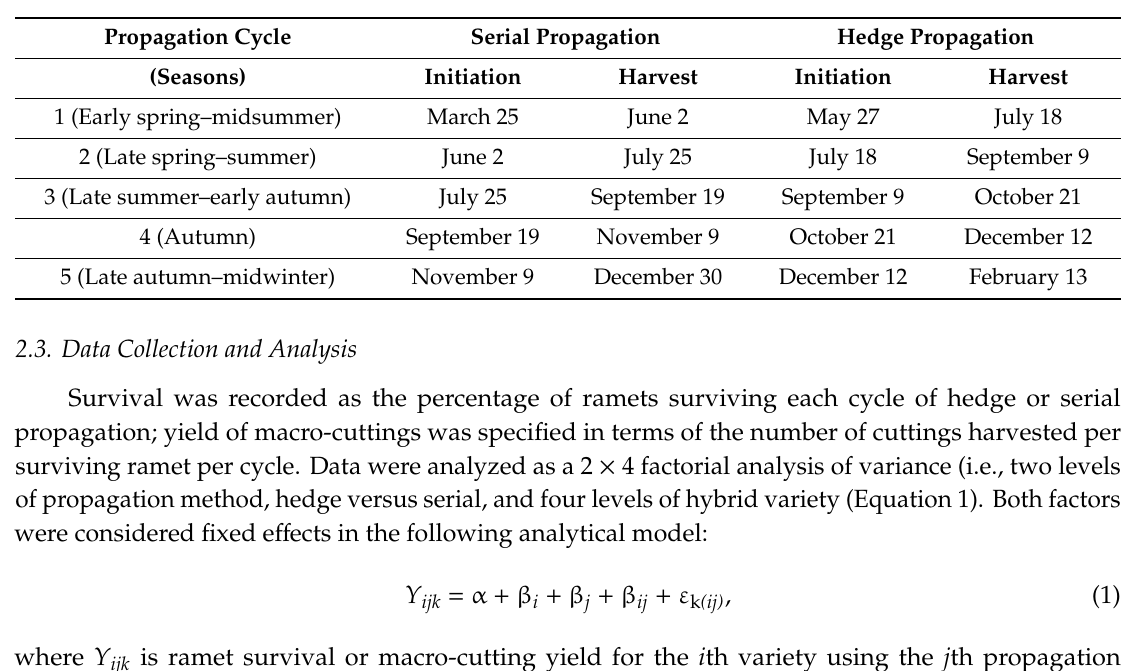
Table 2. Greenhouse schedule of five season cycles of serial and hedge